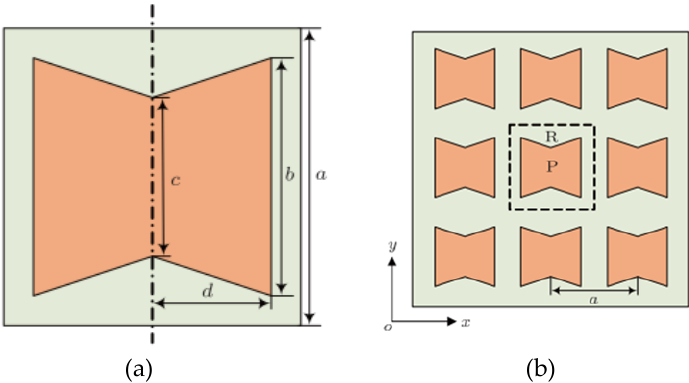
Figure 18. ( a ) The unit cell with spindle-shaped inclusion; ( b ) Schematic view of proposed PC [60].